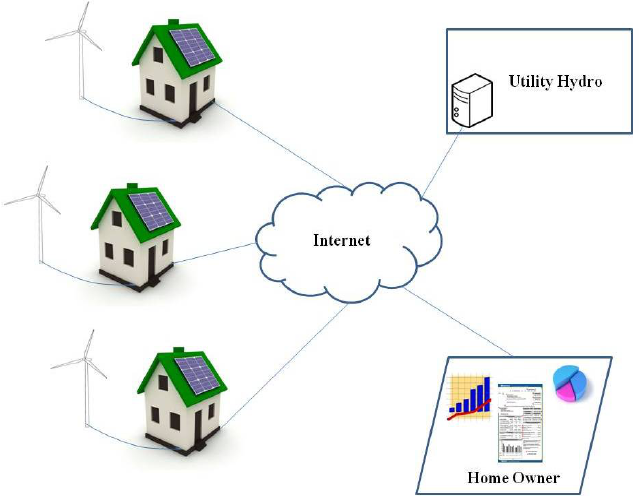
Figure 1. Smart grid applications model using sensor network web